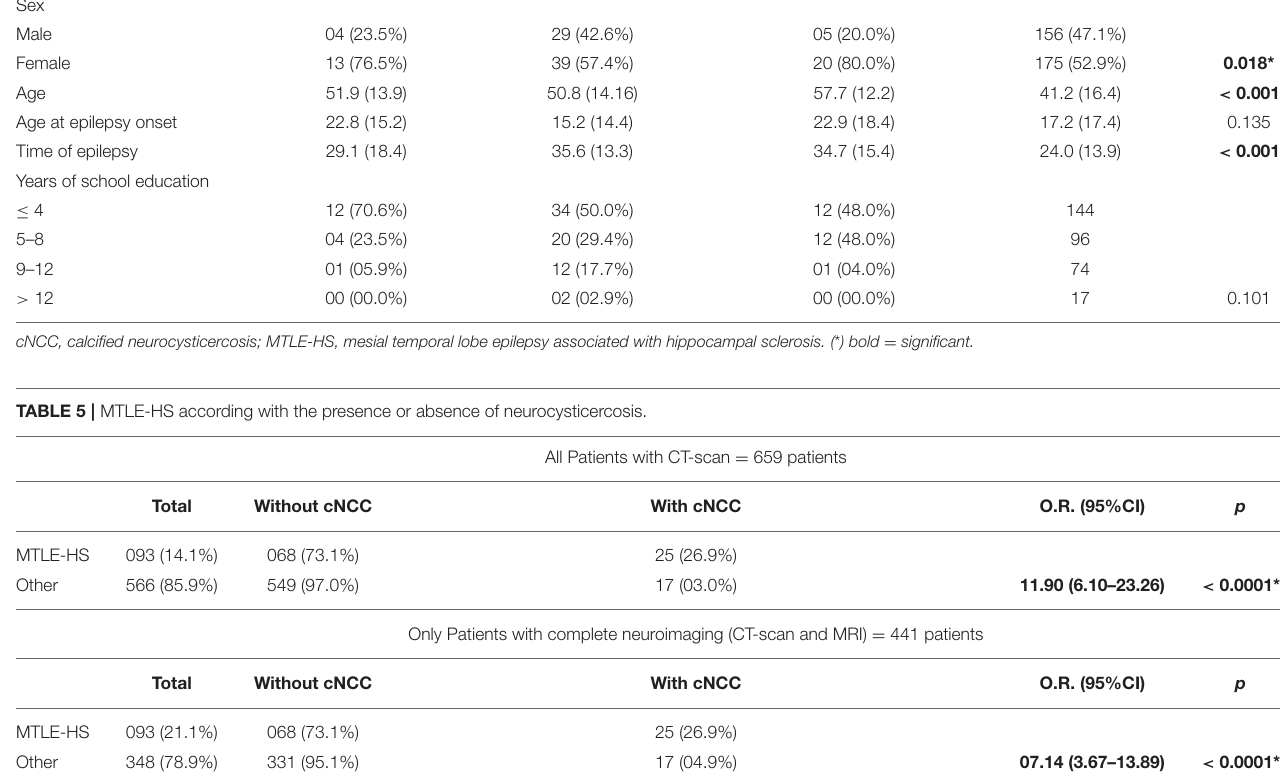
TABLE 4 | Characteristics of patients with complete neuroimaging ( n = 441), divided according with presence of cNCC alone, MTLE-HS alone, MTLE-HS plus cNCC and other forms of epilepsy. Groups variables